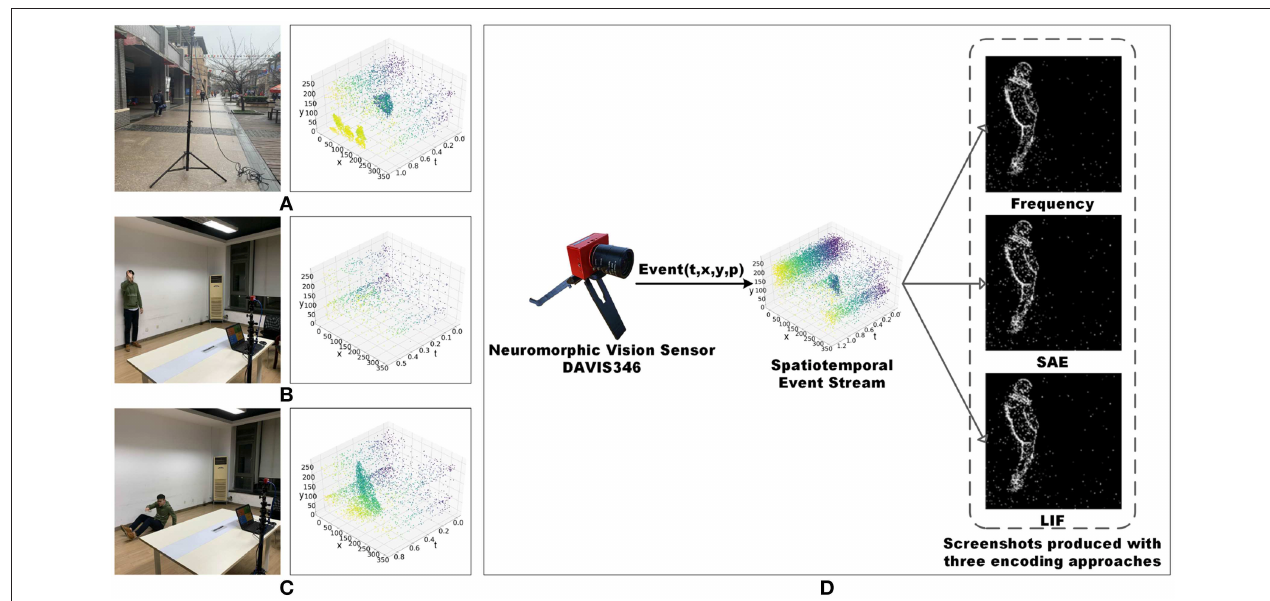
FIGURE 1 | (A) Experiment environment setup of pedestrian recordings and corresponding data visualization. (B) Experiment environment setup of human action recordings and corresponding data visualization. (C) Experiment environment setup of human fall recordings and corresponding data visualization. (D) Encoding process of three methods as Frequency, SAE and LIF. The corresponding produced screenshots are from the pedestrian dataset. We clarify that the human subject’s face in the images is obscured, and the subject has agreed on the publication of this